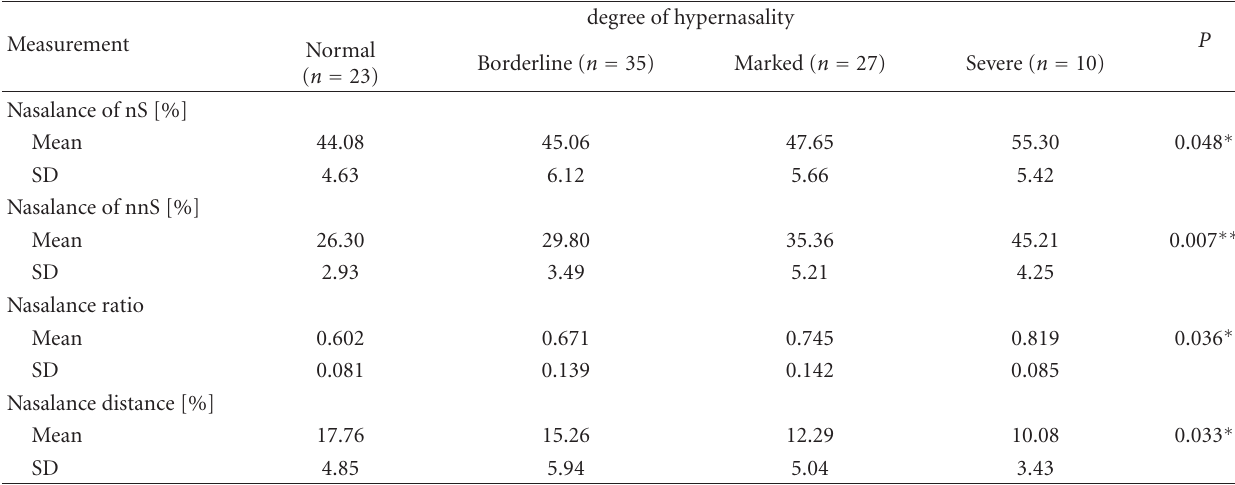
Table 2: Results grouped in di ff erent degrees of hypernasality.